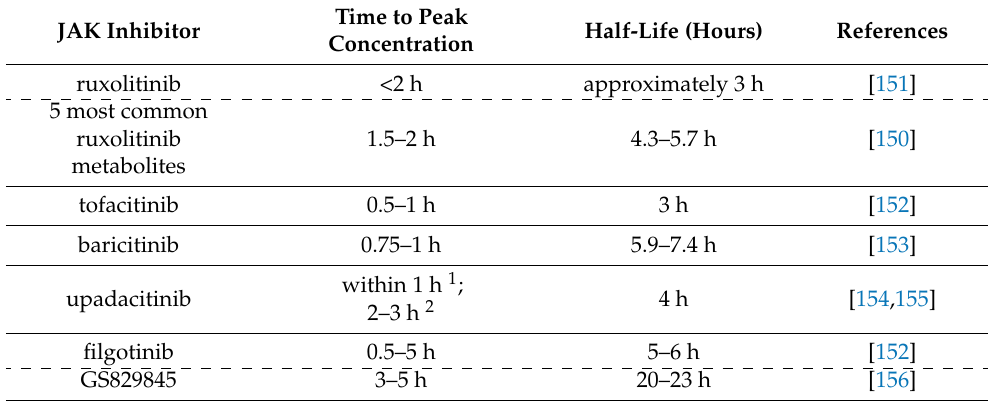
Table 3. Summary of jakinib time to peak concentration and functional half-life. Time to Peak JAK Inhibitor